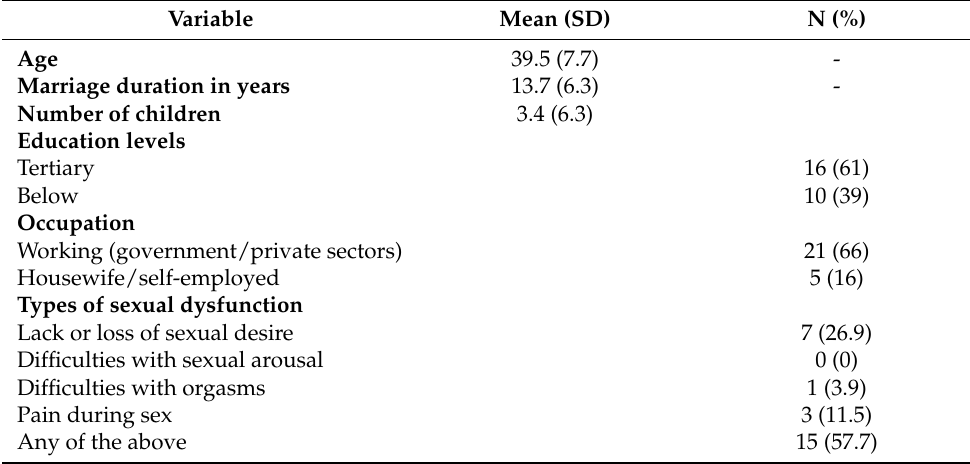
Table 1. Profile of participants ( n = 26).